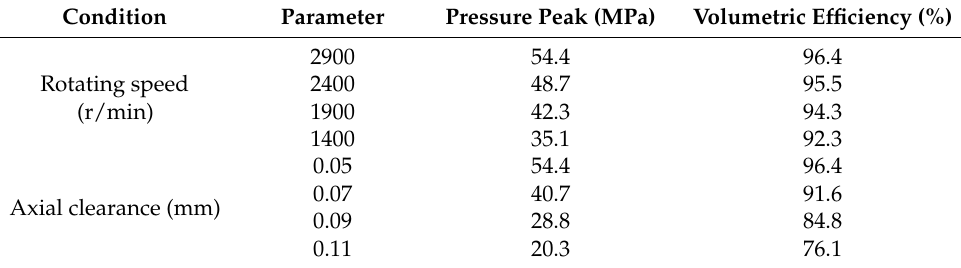
Table 3. Volumetric efficiency at different conditions.